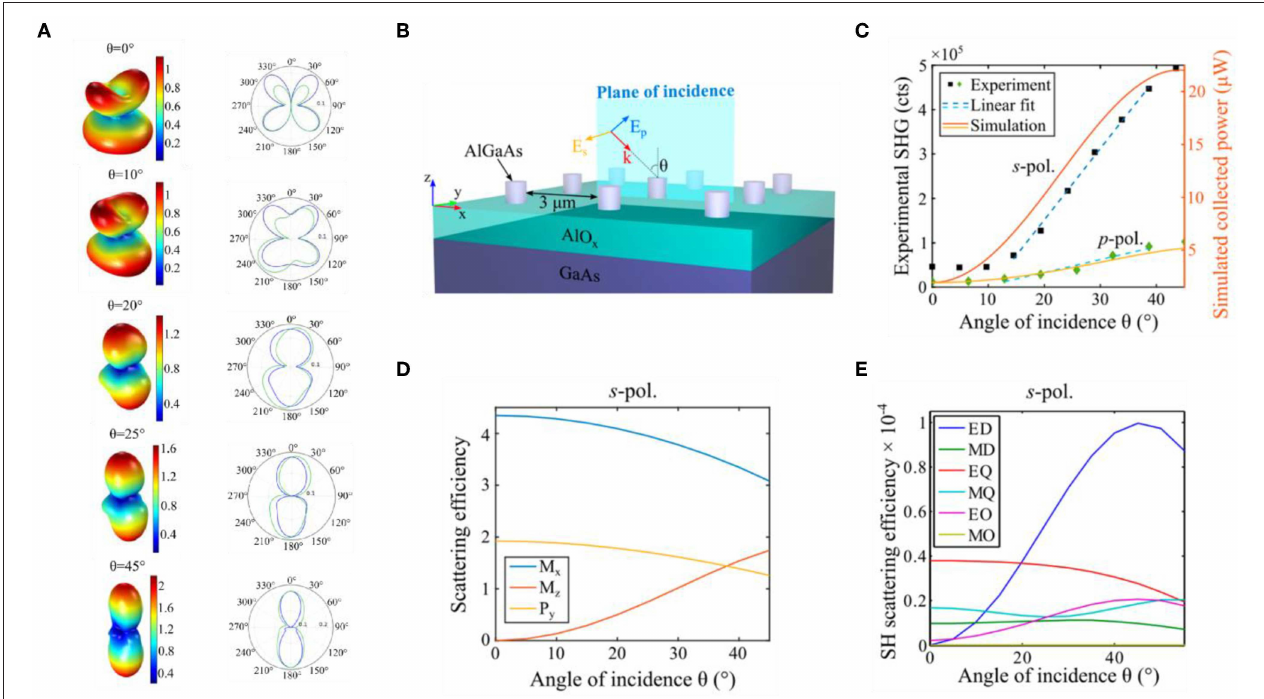
FIGURE 2 | (A) Numerical analysis of SHG in AlGaAs nanocylinders when varying the FF beam incident angle: far-field when moving from a normal incident excitation and s-polarized along [100] to a tilted s-polarized excitation oriented at 45 ◦ from the normal. Reprinted with permission from Carletti et al. [36]. (B) SHG in AlGaAs nanopillars for tilted excitation. Sketch of the analyzed experiment. A plane wave with incidence angle θ impinges on a single pillar with radius 220nm and height 400nm. (C) Numerical and experimental results of back-collected SH when varying θ for linearly s and p polarized FF. (D) Cartesian coordinate multipoles expansion of linear scattering at 1,570nm. Three main contributions are reported here: magnetic dipoles along x and z (solid blue and red lines, respectively) and electric dipole along y (solid yellow line). (E) Spherical harmonics multipole expansion calculated from SH displacement current distribution. Reprinted with permission from Carletti et al.